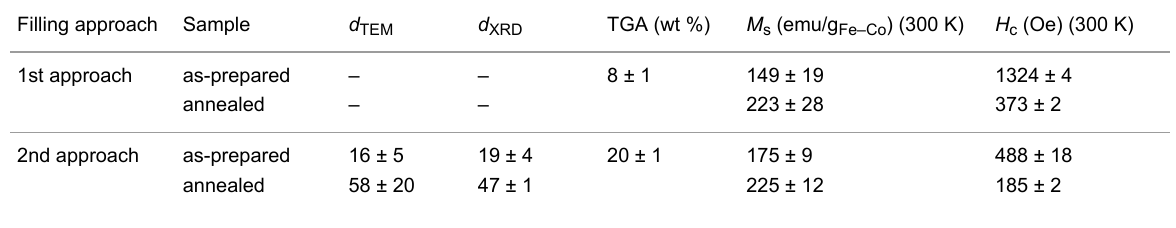
Table 1: Physical properties of the magnetic nanoparticles under study. Filling approach